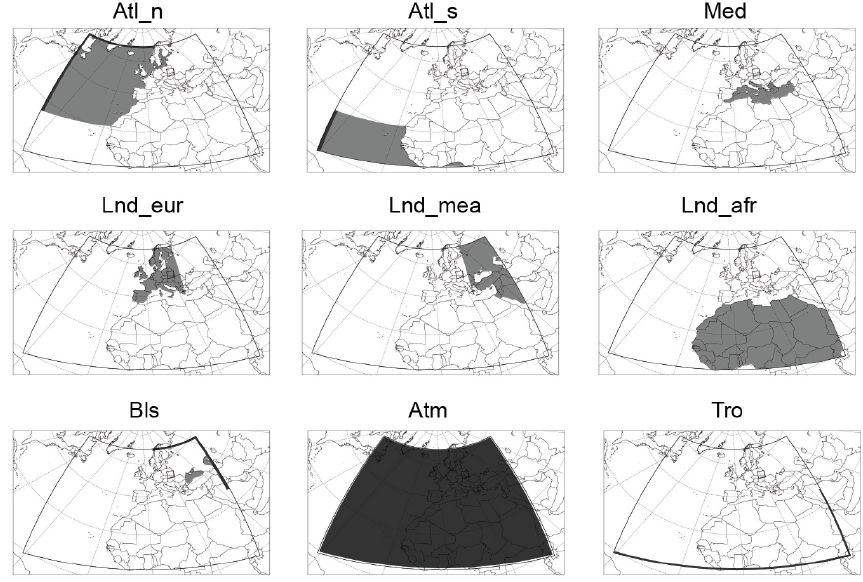
Figure 4. Initialisation set-up of the tagging tracers for the case study of the May 2010 flood event. Light-grey shaded areas show surfaces where evaporating water is tagged. Water tagged within an atmospheric box is shown by dark-grey shading. The small black frame indicates the target region in eastern Europe that was affected by the heavy-precipitation event. The large outer frame corresponds to the model domain.